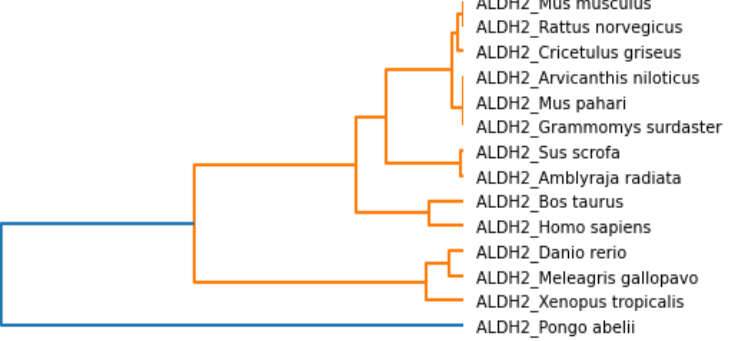
Figure 14. Hierarchical clustering phylogenetic tree based on fractal dimension.